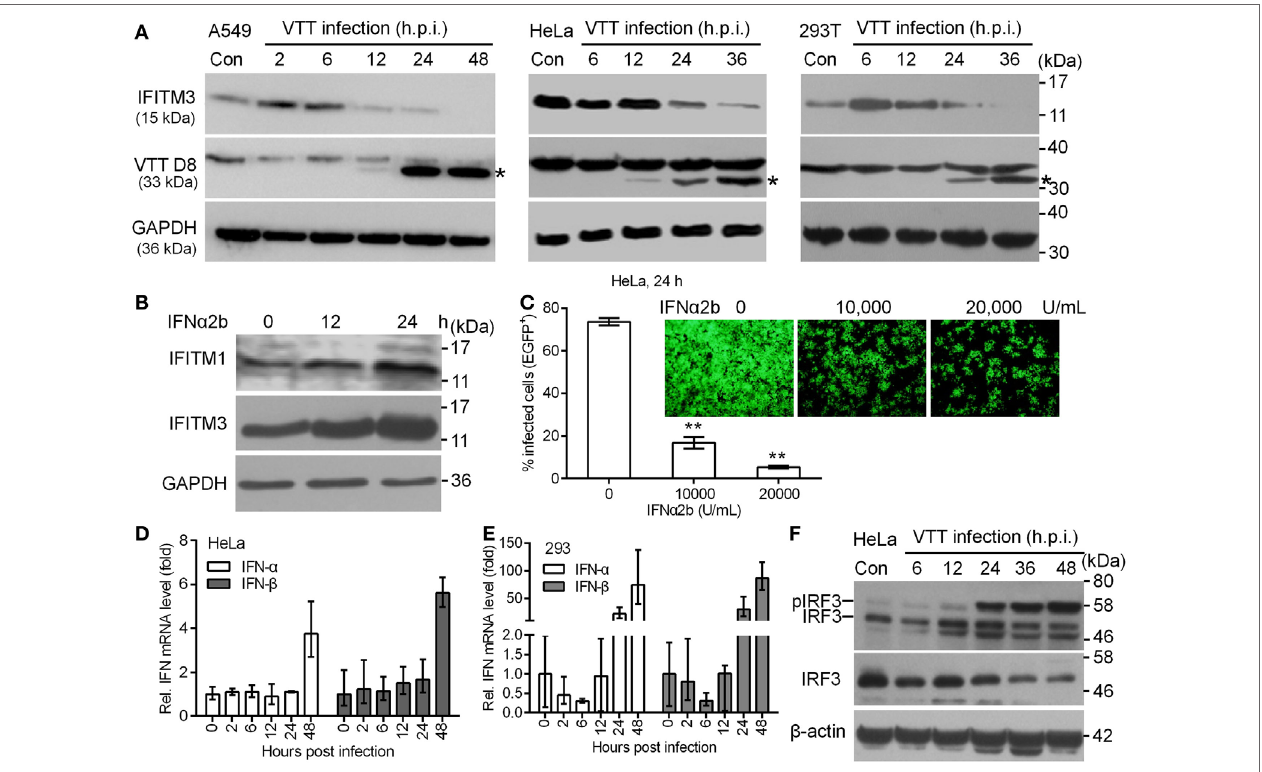
FigUre 1 | Expression kinetics of endogenous interferon-inducible transmembrane protein 3 (IFITM3) protein modulated by virus infection. (a) A549, HeLa, and 293T cells were infected with VACV Tian Tan (VTT) at 0.1 PFU/cell for indicated time points after infection. Total cell proteins were extracted and the expression kinetics of IFITM3 and VTT D8 protein (*) were measured by Western blot and normalized to GAPDH. (B) Western blot analysis of IFITM1 and IFITM3 expression in HeLa cells treated with IFN α 2b (10,000 U/mL) at indicated time point posttreatment. (c) Effect of IFN α 2b at indicated concentrations on vaccinia virus infection in HeLa cells evaluated by flow cytometry and fluorescence microscope. (D,e) qPCR analysis of IFN α and IFN β in HeLa and 293T cells infected by VTT infection at indicated time points postinfection. (F) Western blot analysis of IRF3 expression and phosphorylation in HeLa cells treated by VTT at indicated time points postinfection. ** P <